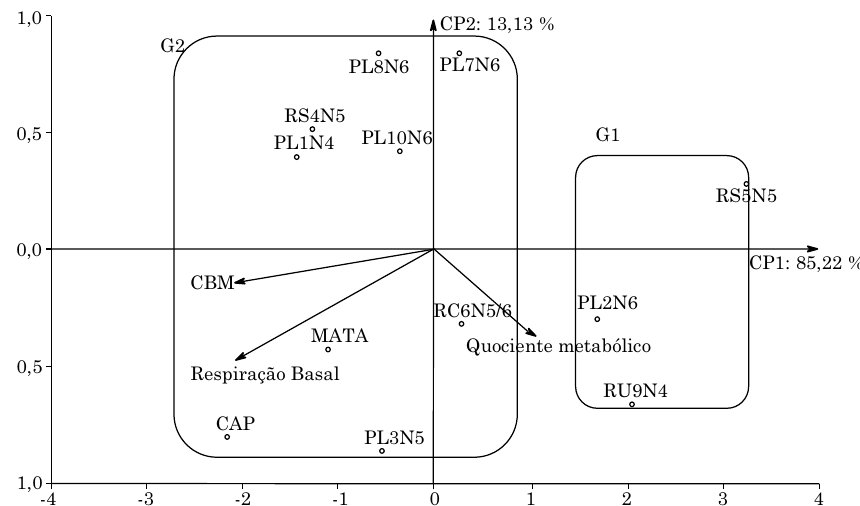
Figura 2. Gráfico biplot construído com os dois primeiros componentes principais, evidenciando a distribuição dos atributos bioquímicos e biológicos avaliados nas áreas.